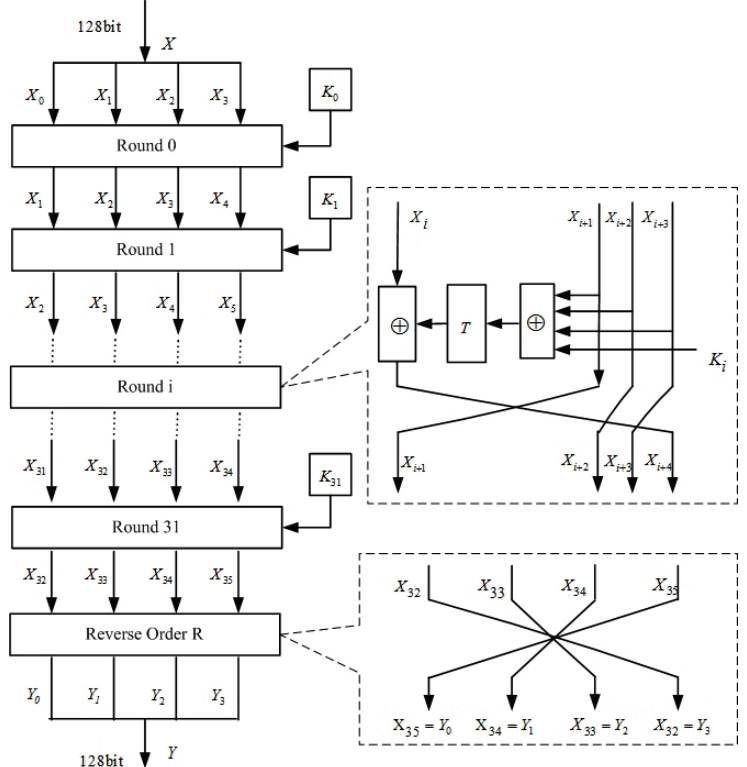
Figure 1. The flow and structure of